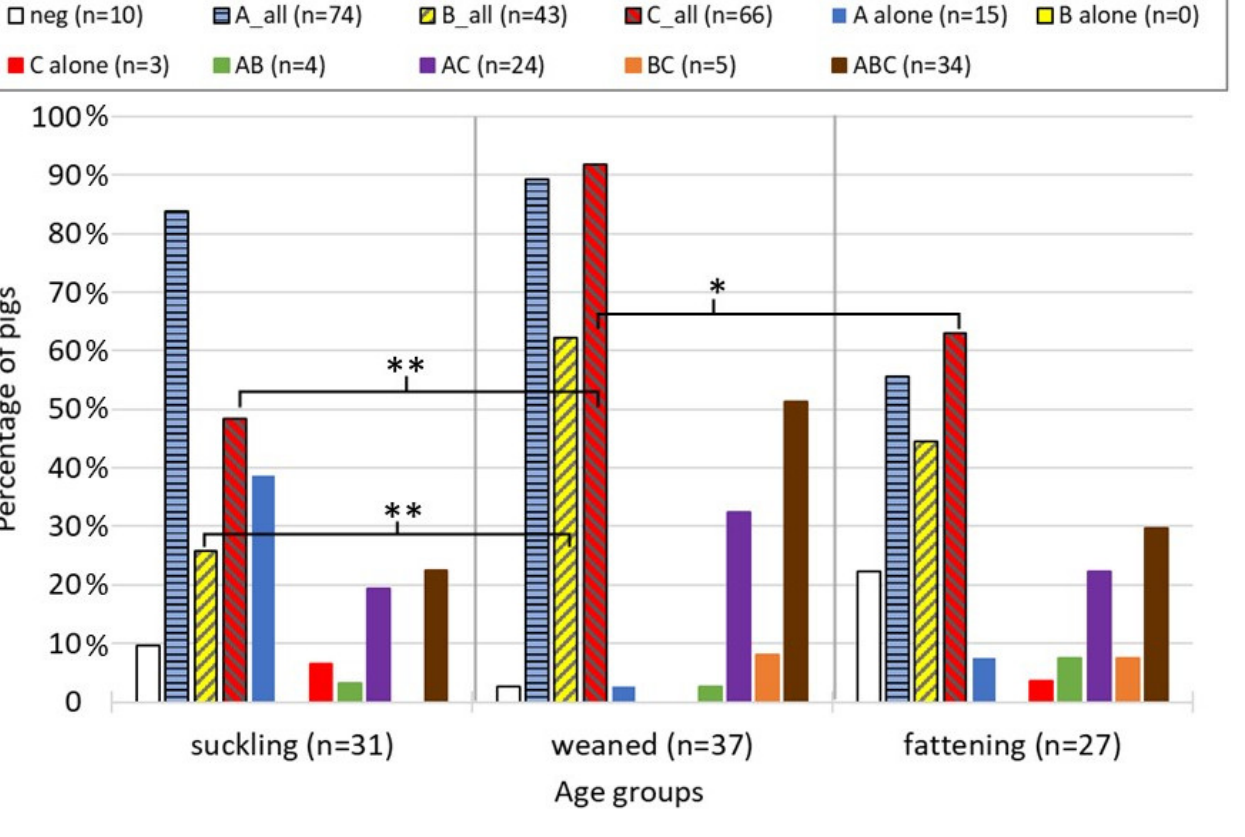
Figure 2. The percentage of pigs from the cross-sectional study ( n = 95) (co-)infected with different types of RV species and grouped by age group is shown. The “_all” indicates that all samples positive for this RV species are included in this group (=overall result), independent of co-infecting species. Statistically significant differences are indicated by asterisks (* p < 0.05, and ** p < 0.005).